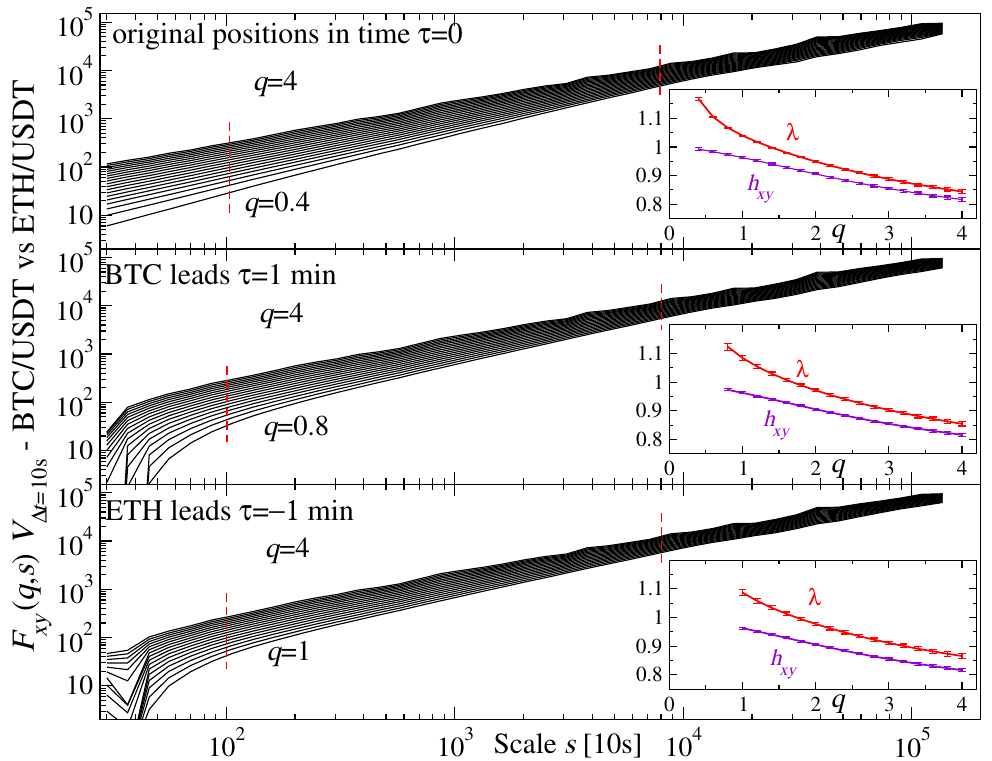
Figure 6. ( Main panels ) Fluctuation functions F XY q ( s ) calculated for the time series of volume traded V ∆ t ( t ) for X = BTC and Y = ETH. In each panel, vertical dashed lines denote a range of time scales s ( s ) . Extreme values of q are also shown. Three cases for which a power-law model can be fitted to F q XY are considered: both time series are simultaneous ( top ), time series representing BTC is advanced by τ = 1 min ( middle ), and time series representing ETH is advanced by τ = 1 min ( bottom ). ( Insets ) The bivariate scaling exponent λ ( q ) vs. the mean univariate scaling exponent h XY ( q ) calculated for the same time series. Error bars denote the standard